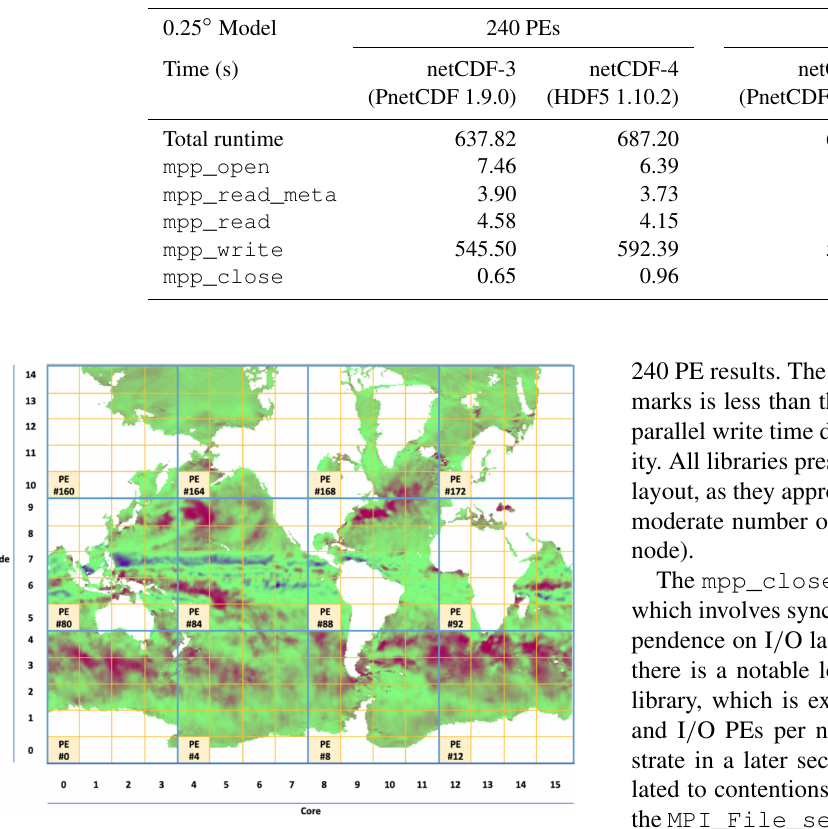
Figure 2. A schematic diagram of 16 × 15 computation domain (grid of yellow-outlined squares) and 4 × 3 I / O domain (grid of blue- outlined squares) with 12 I / O PEs (labelled with filled-in yellow squares) in a 240 PE benchmark. The index of each I / O PE is la-